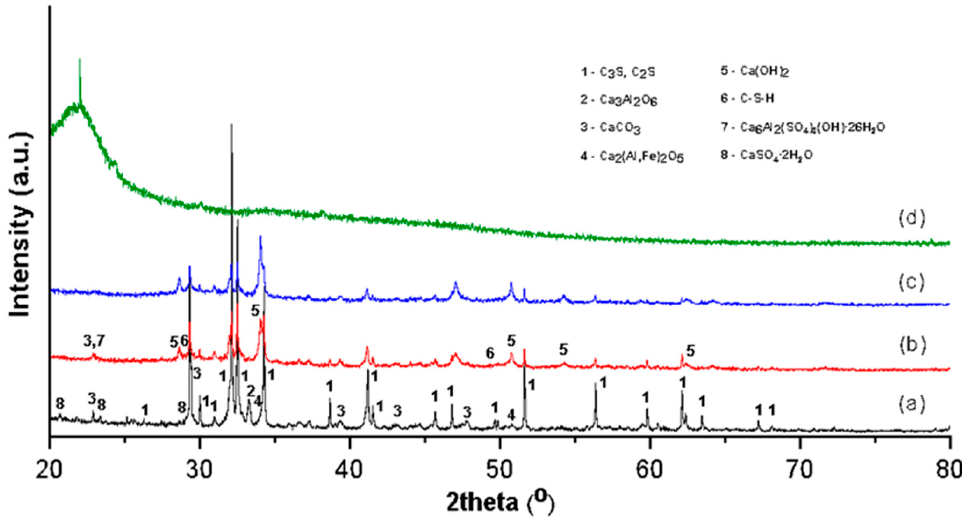
Figure 4. XRD patterns of ( a ) CEM, ( b ) CP, ( c ) CP10VSW and ( d ) VSW samples.